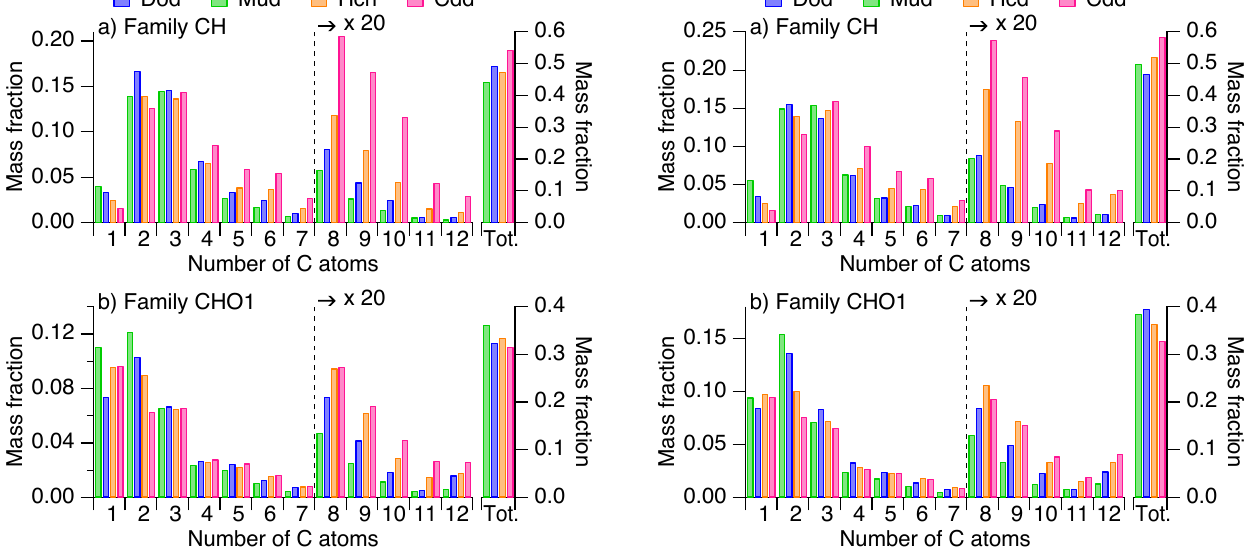
Fig. 6. Contribution of ions detected in the AMS to the bulk organic mass concentration for high-NO x alkane photooxidation. Ions are grouped into families according to the ion atomic composition and displayed as a function of carbon atoms in the ion. Tot. is the sum over all carbon atom numbers for each family. The data represent a 30min average of the SOA formed after 95–100% of the initial alkane had reacted. The data presented are from experiments DH2, MH2, HH2, and CH2.